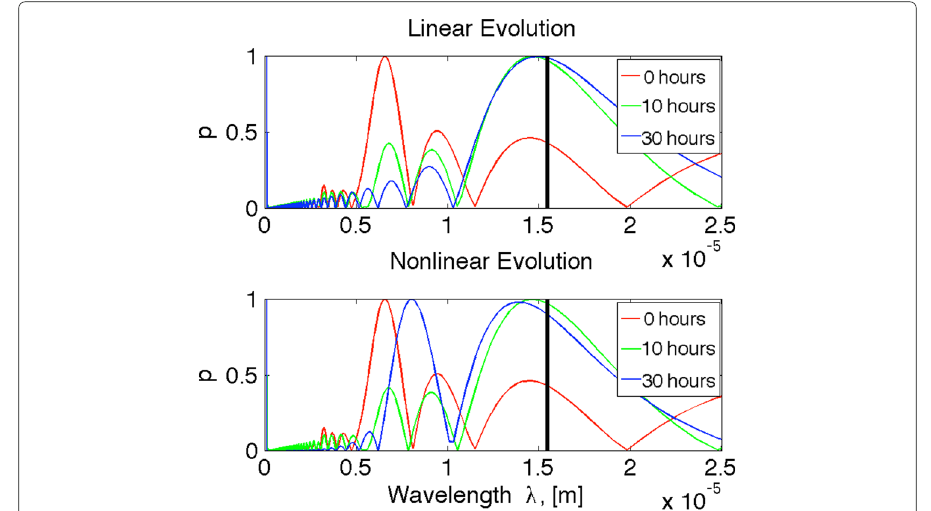
Fig. 7 Wavelength spectrum for linear ( top ) and nonlinear ( bottom ) evolution cases. The distribution function of the surface is shown prior to evolution, after 10 h, and after 30 h to demonstrate the changes throughout evolution. The effect of nonlinearities shows the emergence of a wavelength at later times, which is half the analytical result according to linear theory. After 10 hours, both evolution regimes show similar